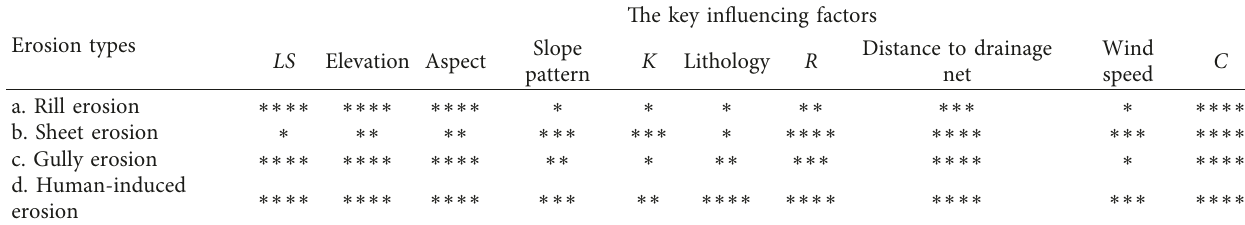
Table 7: Influence degree of each factor on four types of soil erosion within the